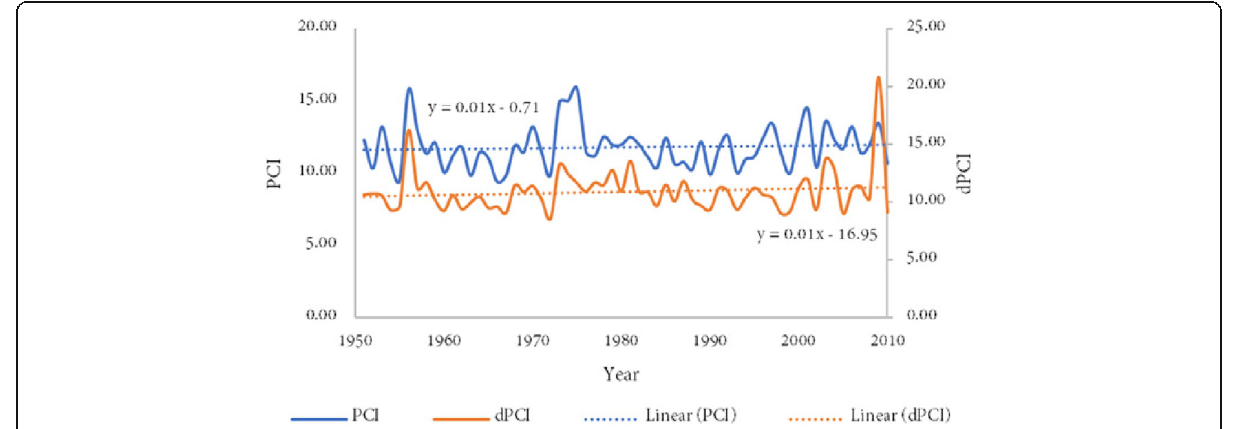
Fig. 4 Trends of PCI and dPCI in the study